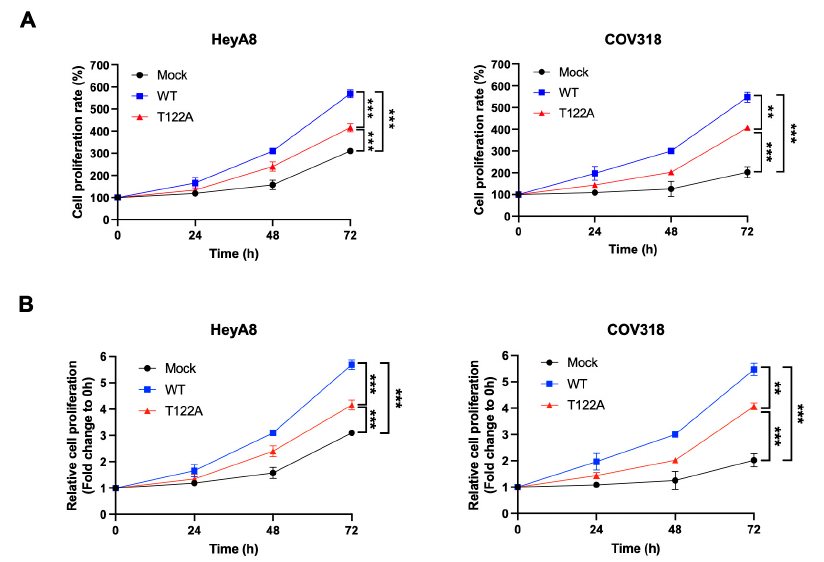
Figure 7. Thr122 phosphorylation of USP13 promotes the proliferation of ovarian cancer cells HeyA8 and COV318 cells were transfected with wild-type USP13 (WT) and phospho-mutant USP13 (T122A). Overexpression of both wild-type USP13 and phospho-mutant USP13 (T122A) in HeyA8 and COV318 cancer cells significantly increased cell proliferation. T122A mutant showed a reduced proliferation rate compared with USP13 wild-type. The cell proliferation at different time points was examined using cell number counting ( A ) and MTT assay ( B ). Statistical data are presented as mean ± SD. Two-tail unpaired Student’s t -test was conducted for statistical analysis (n = 3) (** p -value < 0.01, *** p -value < 0.001).